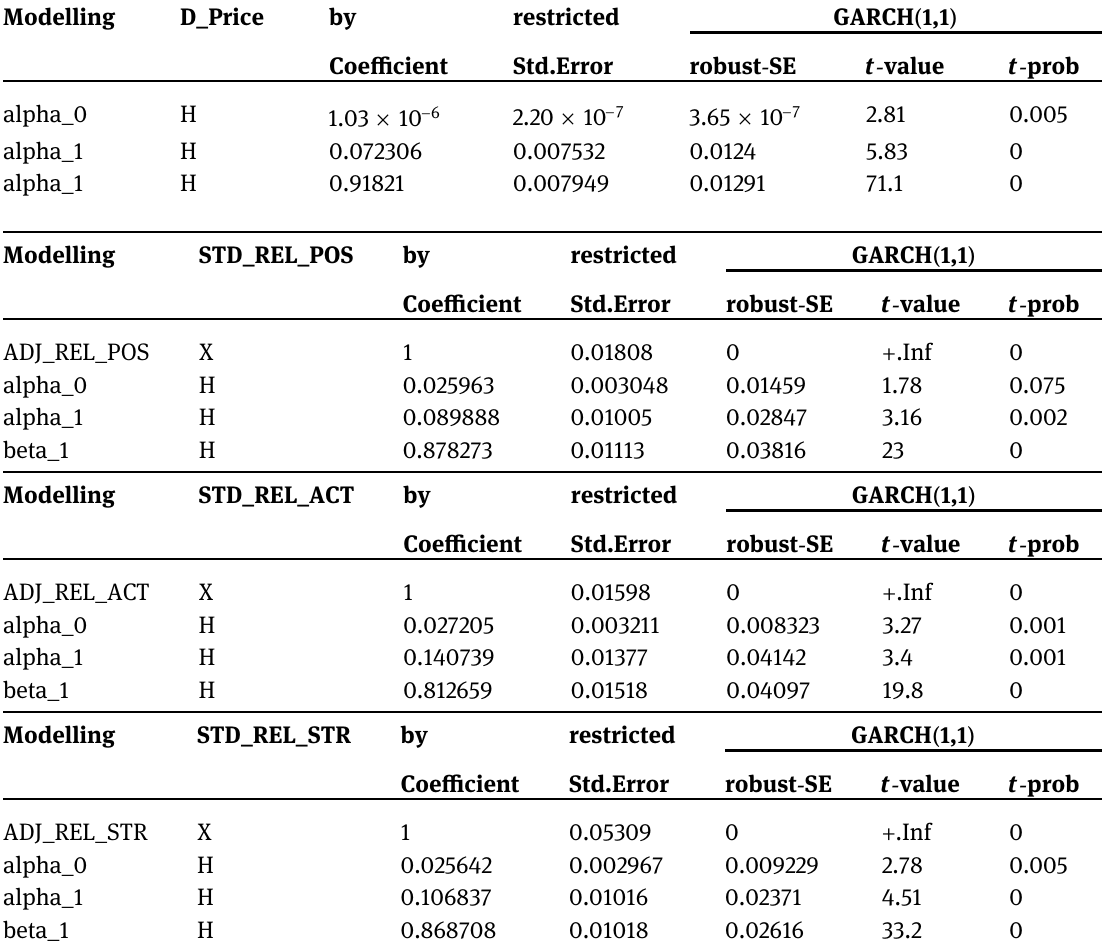
Table A4: S&P 500 returns: GARCH model